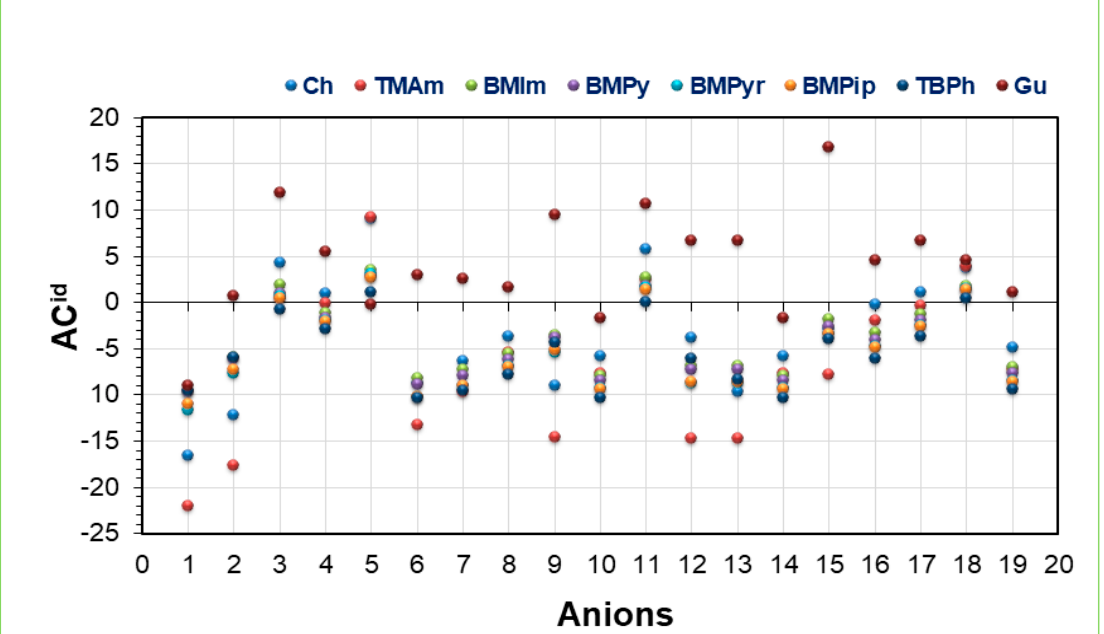
Figure 3. Activity coefficients of the studied ILs for Ibf.